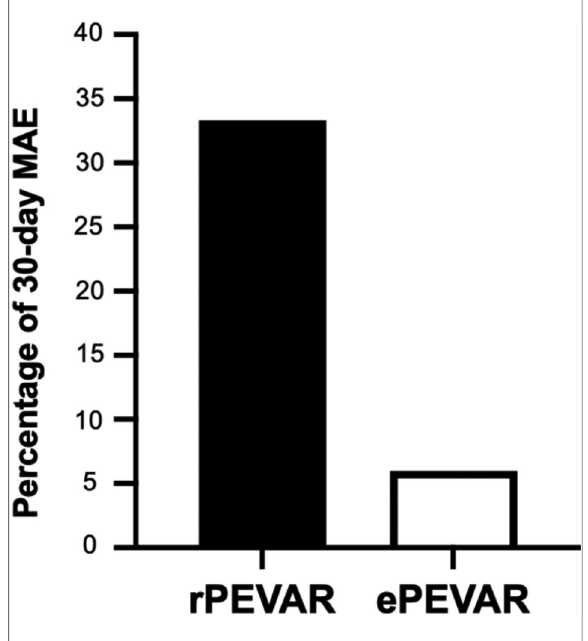
FIGURE 1 Relative percentage difference in 30-day major adverse events (MAE) between patients that underwent rPEVAR versus